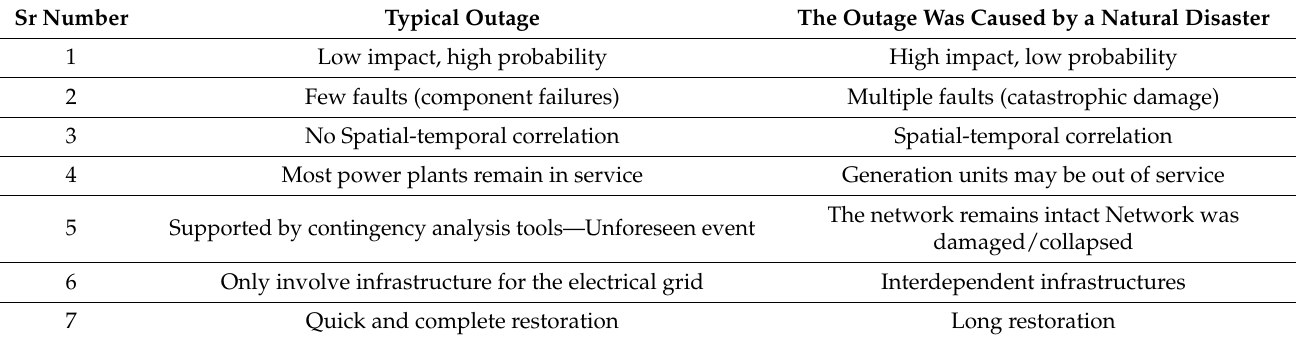
Table 3. Outage comparison between typical and natural disaster outages